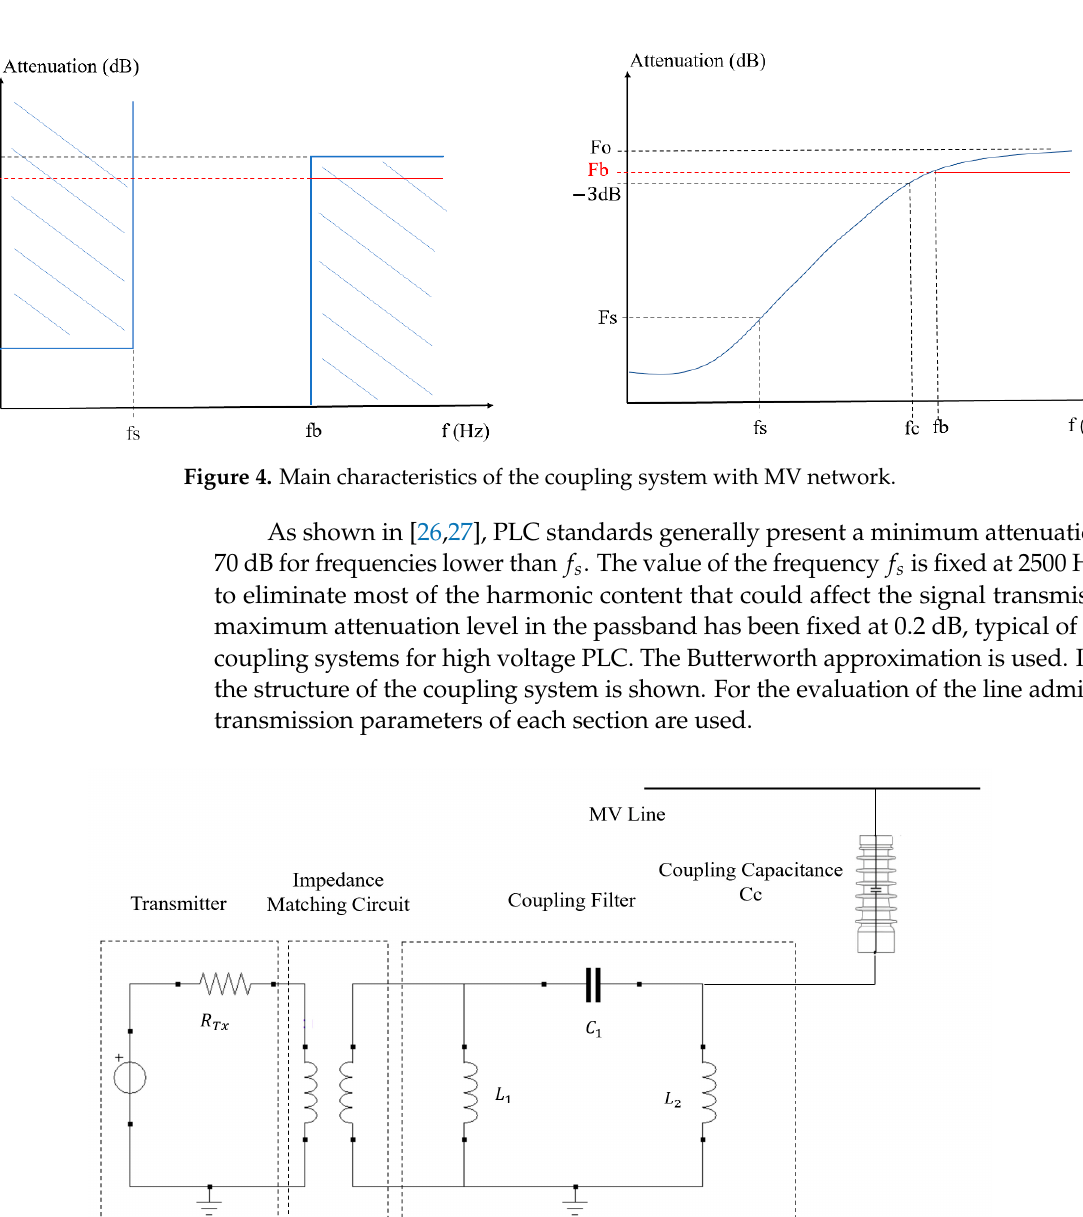
Figure 5. Structure of the coupling system.